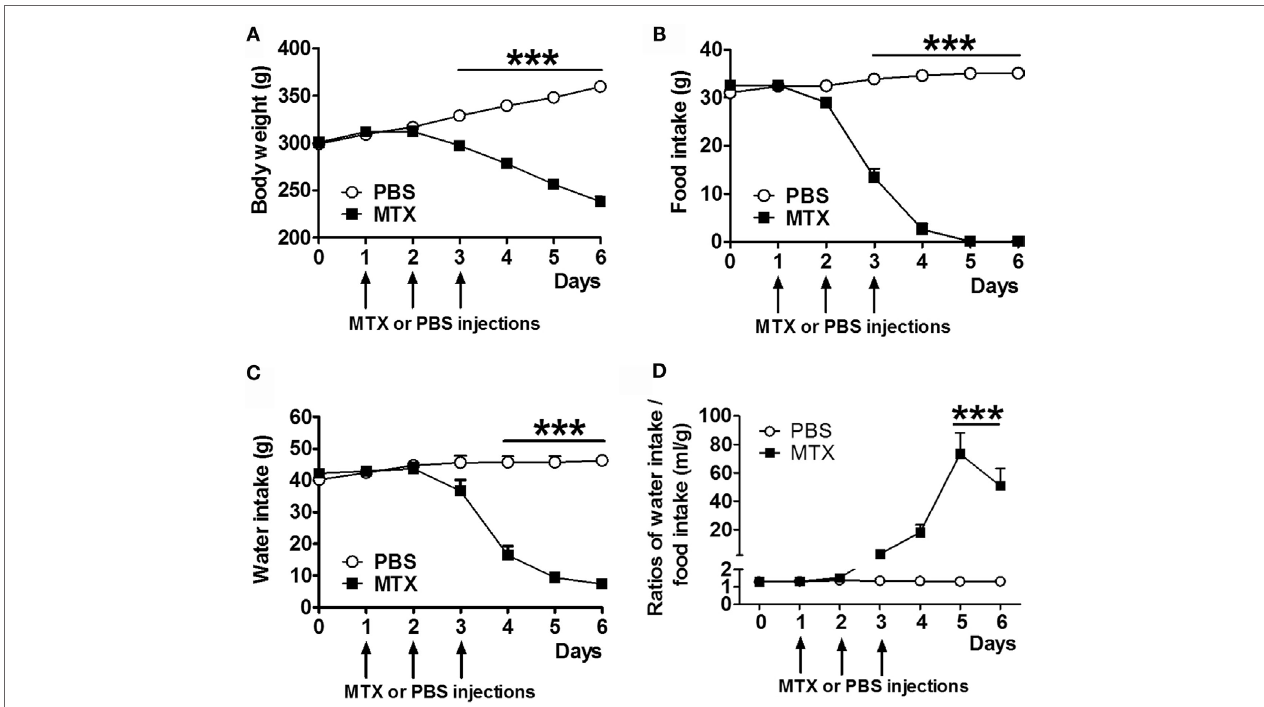
FigUre 1 | Body weight (a), daily food intake (B), and water intake (c) of MTX-treated and PBs-treated control rats (both, n = 10) . Ratios of daily water to food intakes (D) . Two-way RM ANOVA with Bonferroni post-tests *** p < 0.001, effects of time p < 0.0001 (mean ±